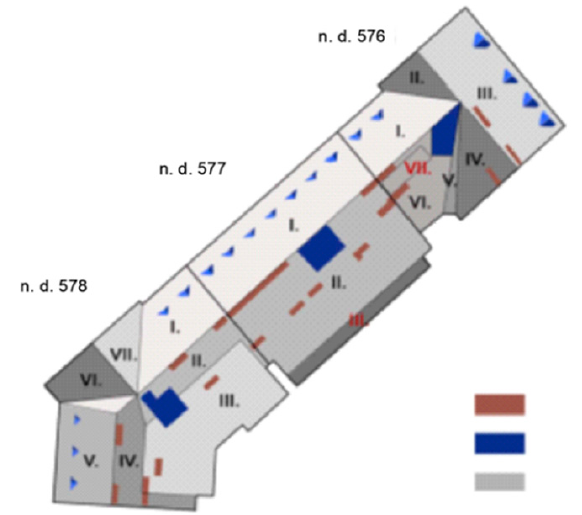
Figure 18. Demonstration of the roof surfaces of a cluster of buildings within an experiment.